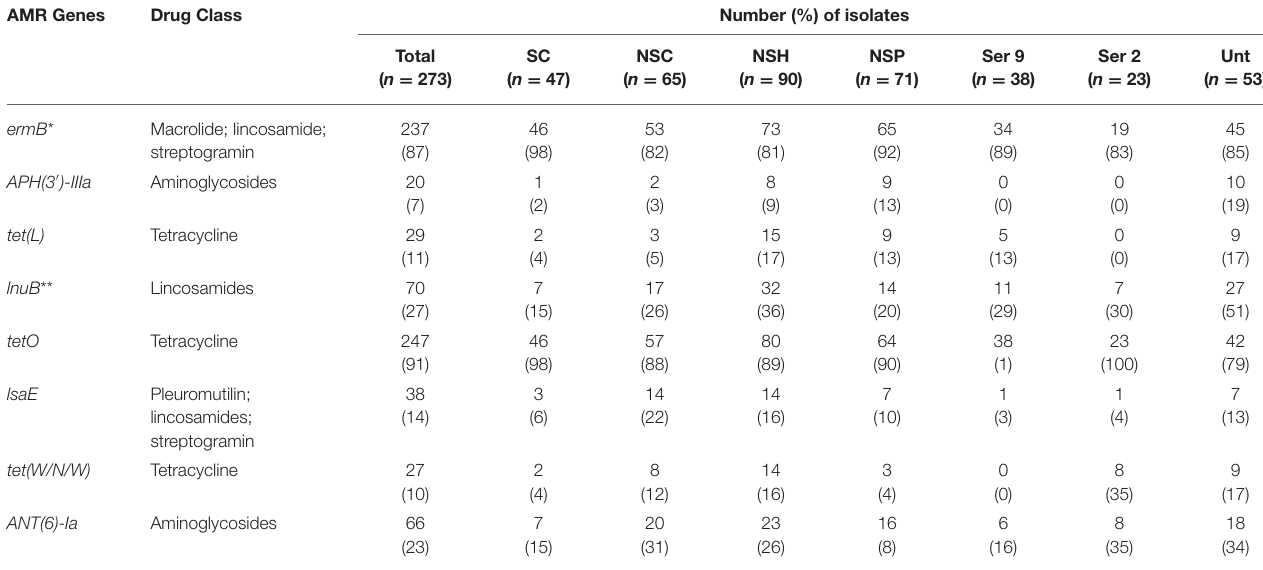
TABLE 5 | Distribution and frequency of most prevalent antimicrobial resistance genes in 273 S. suis isolates in SC, NSC, NSP, and NSH groups. AMR